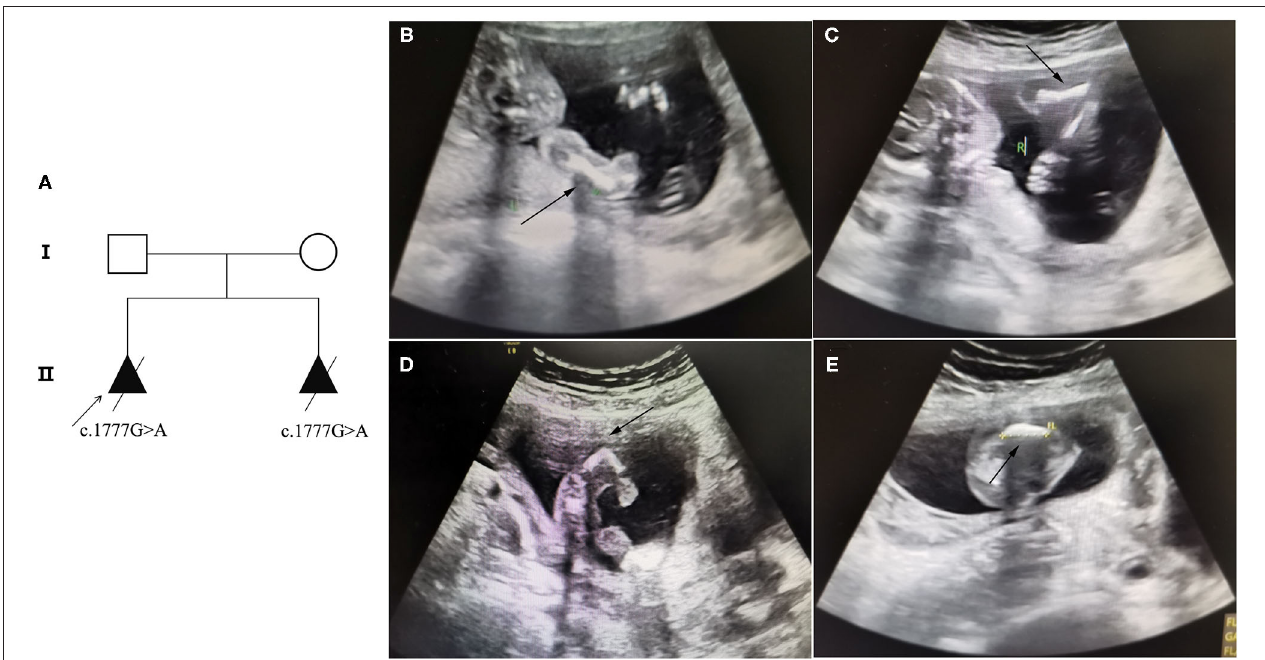
FIGURE 1 | Pedigree information and ultrasound anomalies detected in the fetus. (A) Pedigree information in this family. (B,C) Ultrasound results showing that the bilateral humerus of the fetus was slightly curved. (D) The ultrasound results revealing that the left femur of the fetus was shorter and bent into an angle. (E) The ultrasound results suggested that the right femur of the fetus was shorter and slightly curved. The arrows indicate the